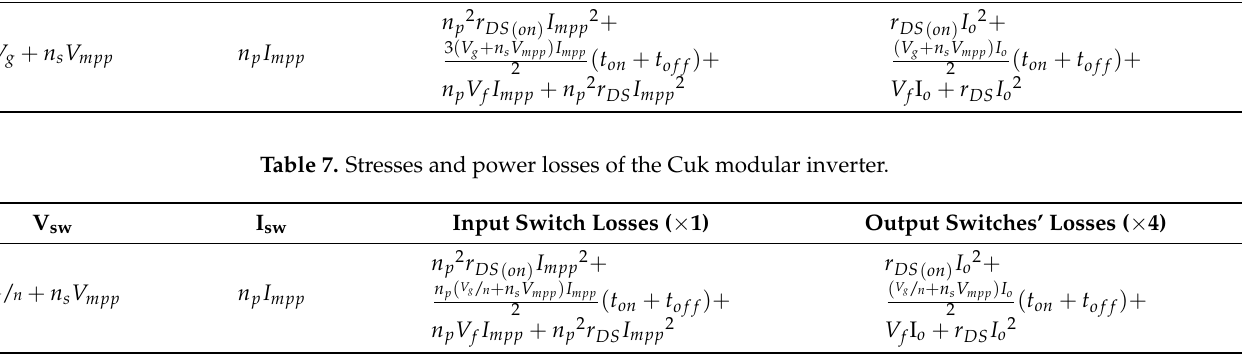
Table 6. Stresses and power losses of the Cuk central inverter.